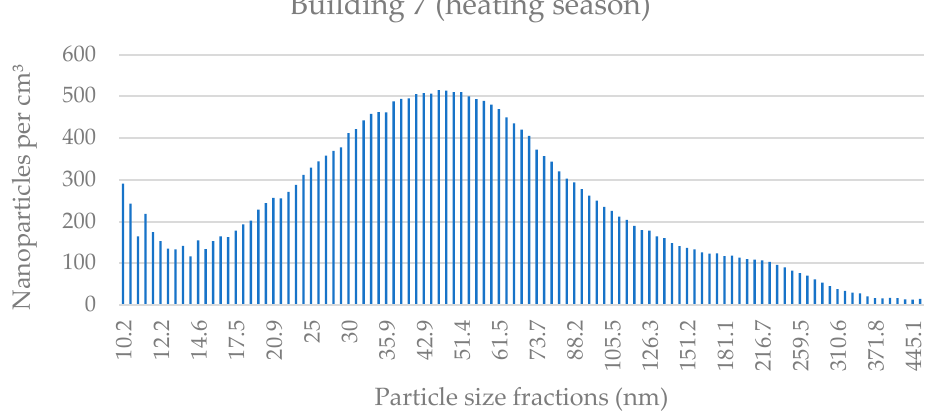
Figure A14. The average nanoparticle concentration in each size fraction in Building 7 during a one- week measurement period during the nonheating season. Figure A15. The average nanoparticle concentration in each size fraction in Building 8 during a one- week measurement period during the heating season.